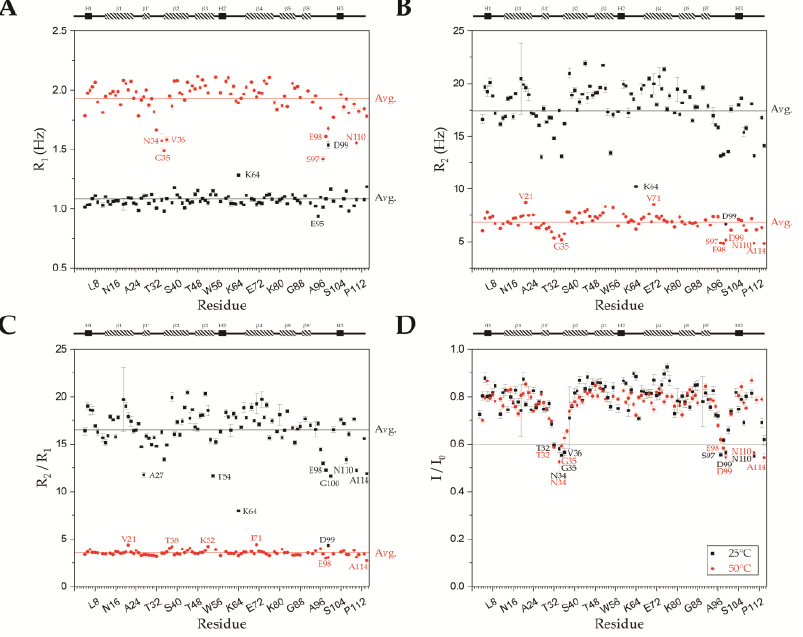
Figure 6. SsoSSB 1–114 backbone dynamics. Per residue ( A ) spin-lattice relaxation (R 1 ), ( B ) spin-spin relaxation (R 2 ), ( C ) R 2 /R 1 ratios, and ( D ) hetNOE values at 25 °C and 50 °C are shown. Errors of the measurement are indicated by black and red lines. In panels A–C, average values of each parameter are indicated with a black (25 °C) or red (50 °C) line. Residues that differed from the average by more than 2 standard deviations are labeled. In panel ( D ), the hetNOE value 0.6 is indicated with a black line. Residues with values lower than 0.6 are labeled in black (25 °C) or red (50 °C). The secondary structure from UniProt is shown at the top of the graph.